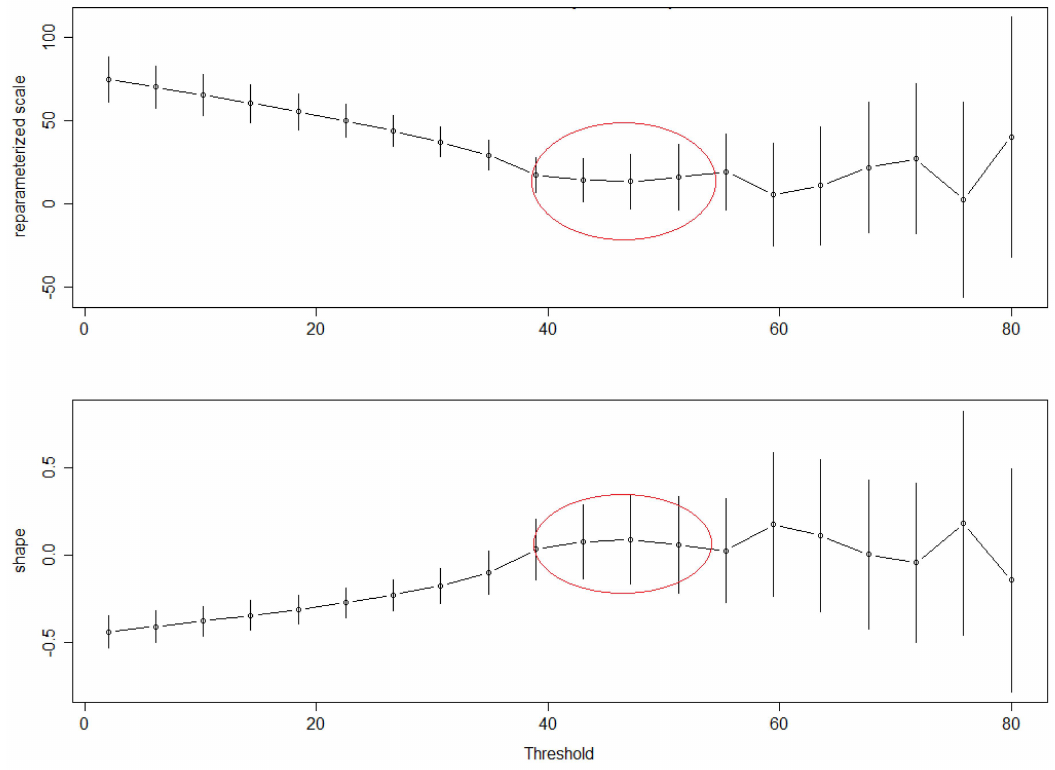
Figure A8. Parameter estimates against threshold for daily rainfall data at Patargo